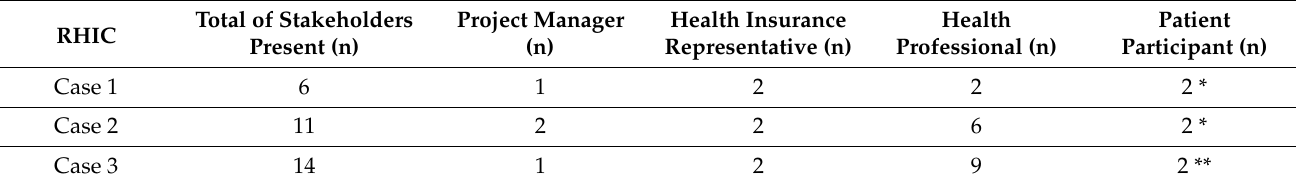
Table 1. Stakeholders in the observed